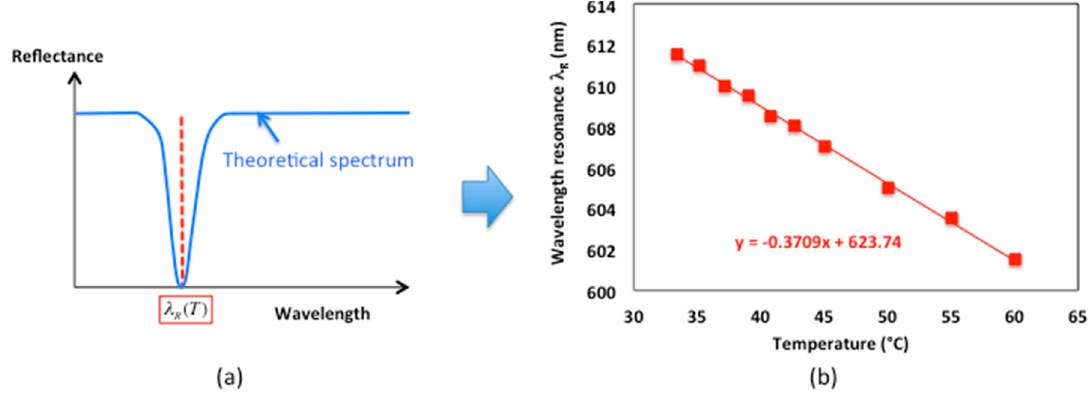
Figure 6. ( a ) Determination of the theoretical resonance wavelength in the spectrum for each Figure6. ( a )Determinationofthetheoreticalresonancewavelengthinthespectrumforeachtemperature; temperature; ( b ) Linear dependence of the theoretical resonance wavelength versus temperature. ( b ) Linear dependence of the theoretical resonance wavelength versus